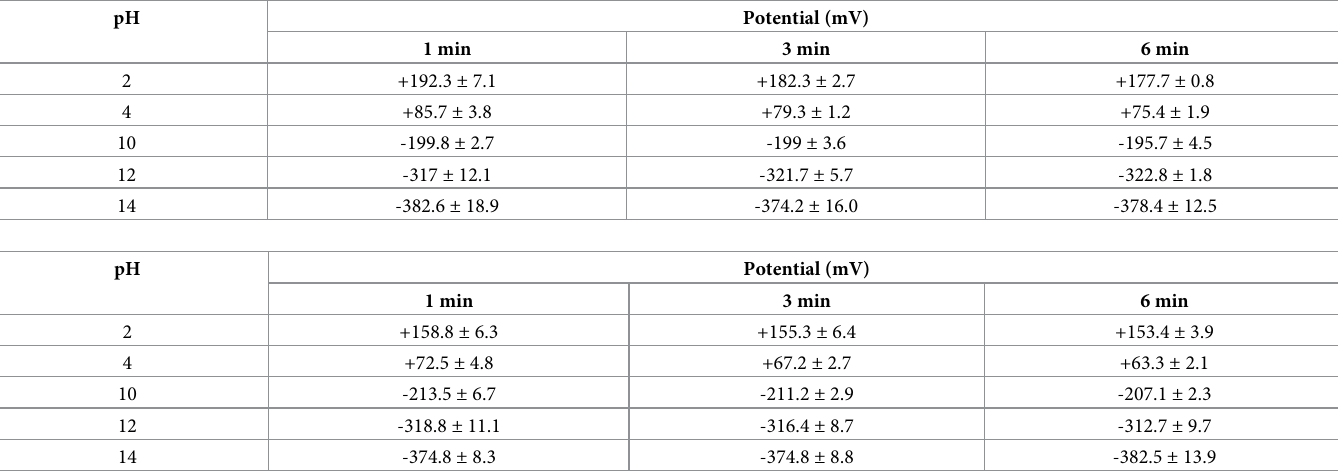
Table 2. Platinum electrodes replacing stainless steel electrodes. (a) Electrical potentials between acids (HCl) and neutral solutions (containing 1 μ M NaCl), and bases (NaOH) and neutral solutions (containing 1 μ M NaCl) a . (b) Electrical potentials between acids (HNO 3 ) and neutral solutions (containing 1 μ M NaCl), and bases (KOH) and neutral solutions (containing 1 μ M NaCl) a .